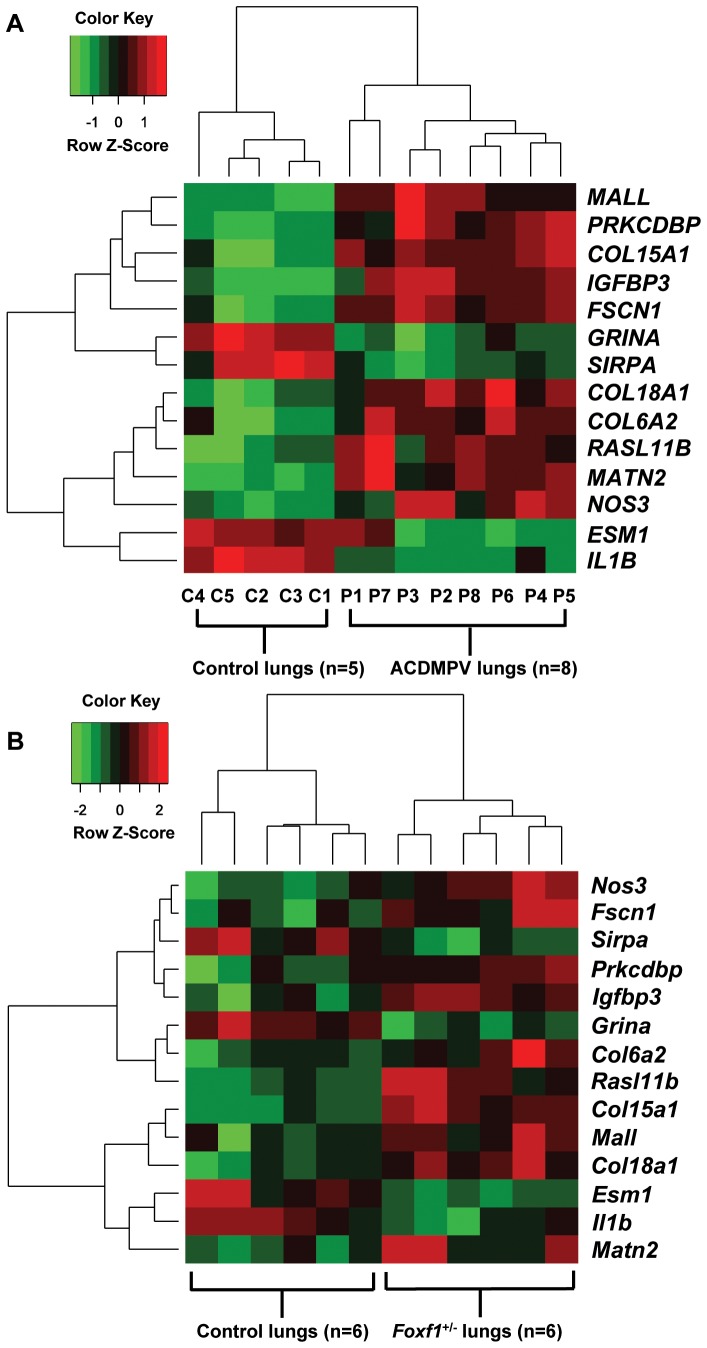
Deregulated genes common to both ACDMPV lungs and P0.5 Foxf1+/− lungs.
(A) Heat map comparing expression of 14 overlapping genes in ACDMPV lung samples and control lung samples; (B) Heat map comparing expression of 14 overlapping genes in Foxf1
+/− lung samples and control lung samples.